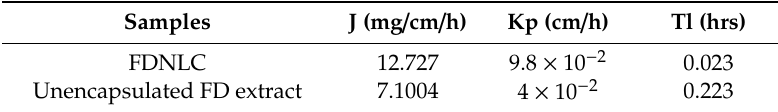
Figure 7. Cumulative amount of FD permeated for 24 h using Strat-M as the membrane. Table 3. Permeation parameters for FDNLC and FD extract for the penetration study using Strat-M as the